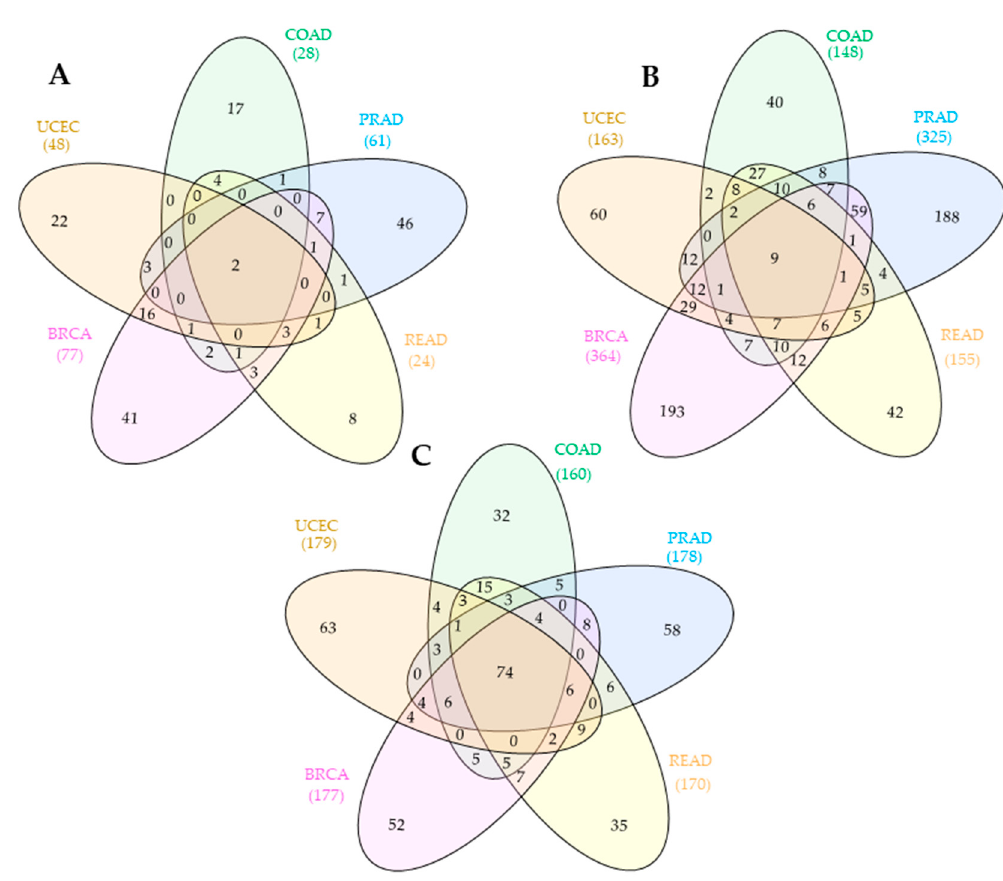
Figure 2. Venn diagram representations for the number of lncRNAs ( A ), mRNAs ( B ), and microRNAs ( C ) involved in individual/shared HD cancer competing endogenous RNA network(s).